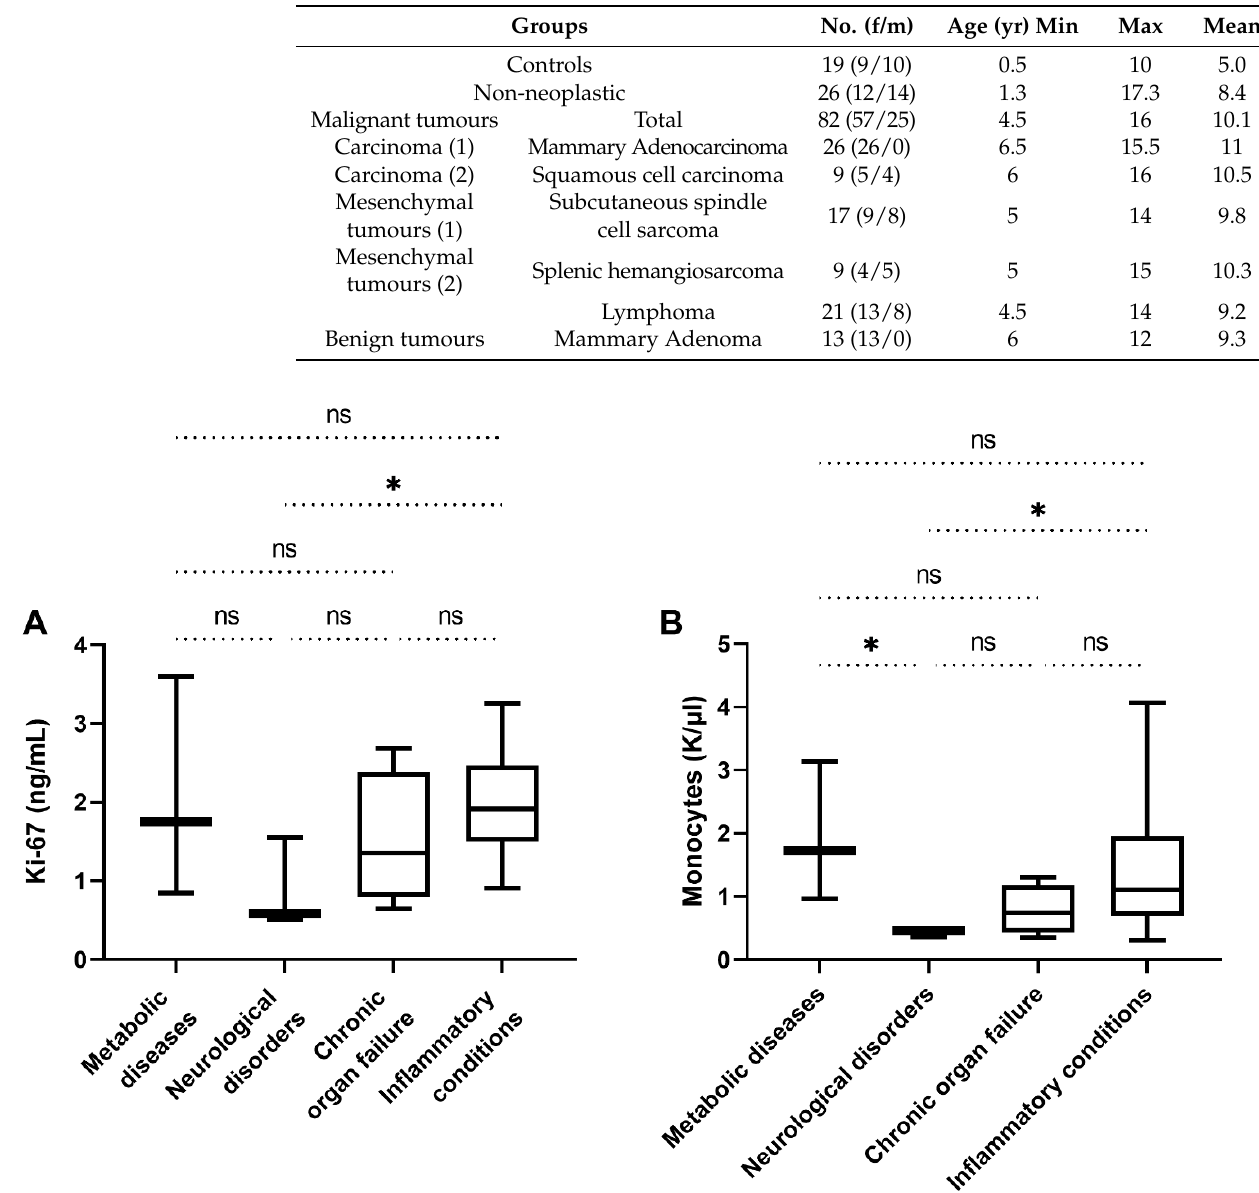
Figure 1. Serum Ki-67 concentrations and monocyte blood counts within the group of dogs with non-neoplastic diseases. ( A ) Comparing the Ki-67 levels, no significant difference between dogs with metabolic disorders, neurological disorders, inflammatory conditions, or organ failure could be found ( p = 0.11), apart from significantly higher Ki-67 concentration in dogs with inflammatory diseases in comparison to dogs with neurological disorders ( p = 0.02). ( B ) Monocyte blood counts were significantly lower in the neurologic disorder subgroup compared with the metabolic and inflammatory disease subgroups ( p = 0.025 and p = 0.03). There was no significant difference between the other subgroups of the non-neoplastic diseased dogs. (ns) not significant; (*) p < 0.05.